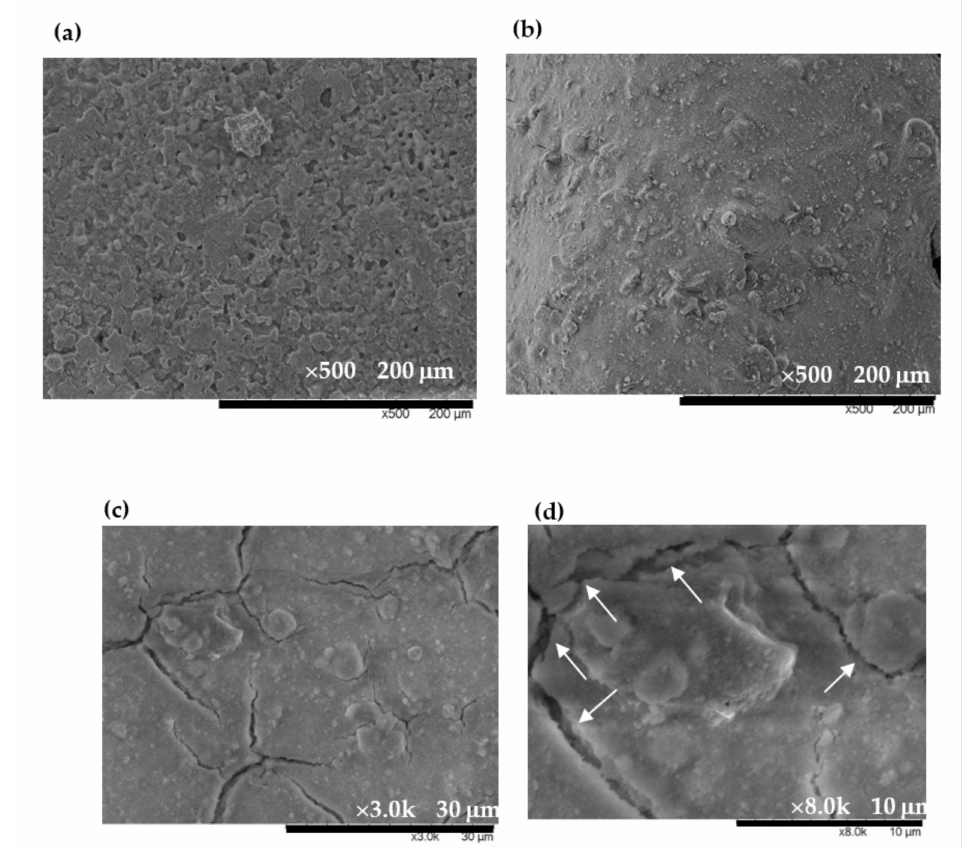
Figure 3. SEM micrographs of ( a ) EuCl 2 film, ( b ) Eu 2 O 3 film, ( c ) 7 wt% EuCl 2 /Eu 2 O 3 blend film and ( d ) high-magnification image of EuCl 2 /Eu 2 O 3 blend